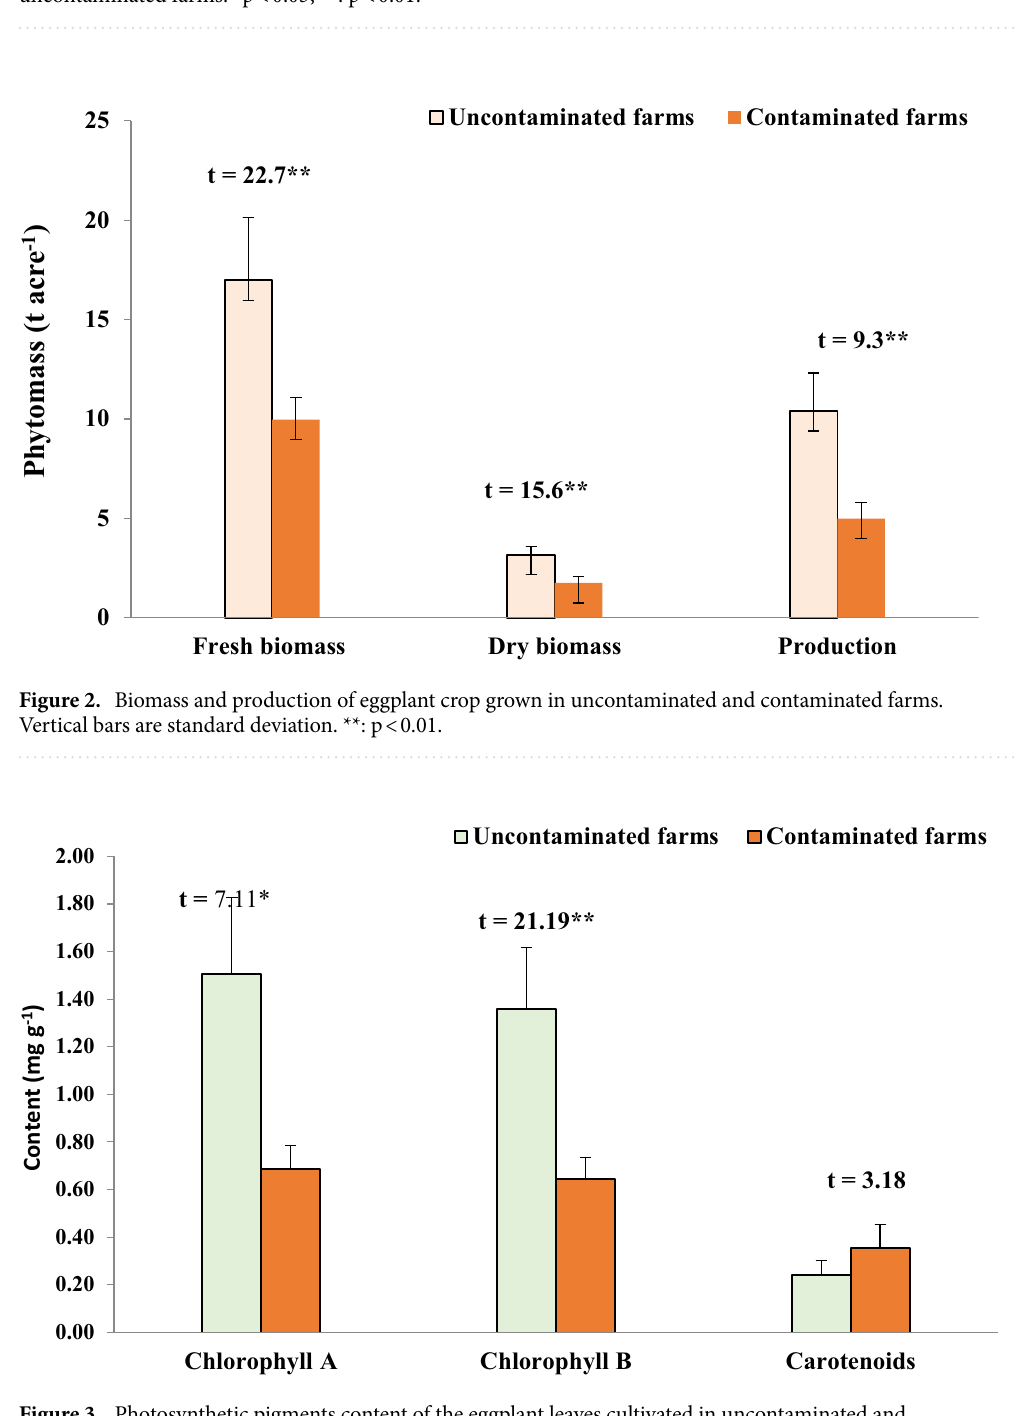
Figure 3. Photosynthetic pigments content of the eggplant leaves cultivated in uncontaminated and contaminated farms. Vertical bars are standard deviation. **: p <